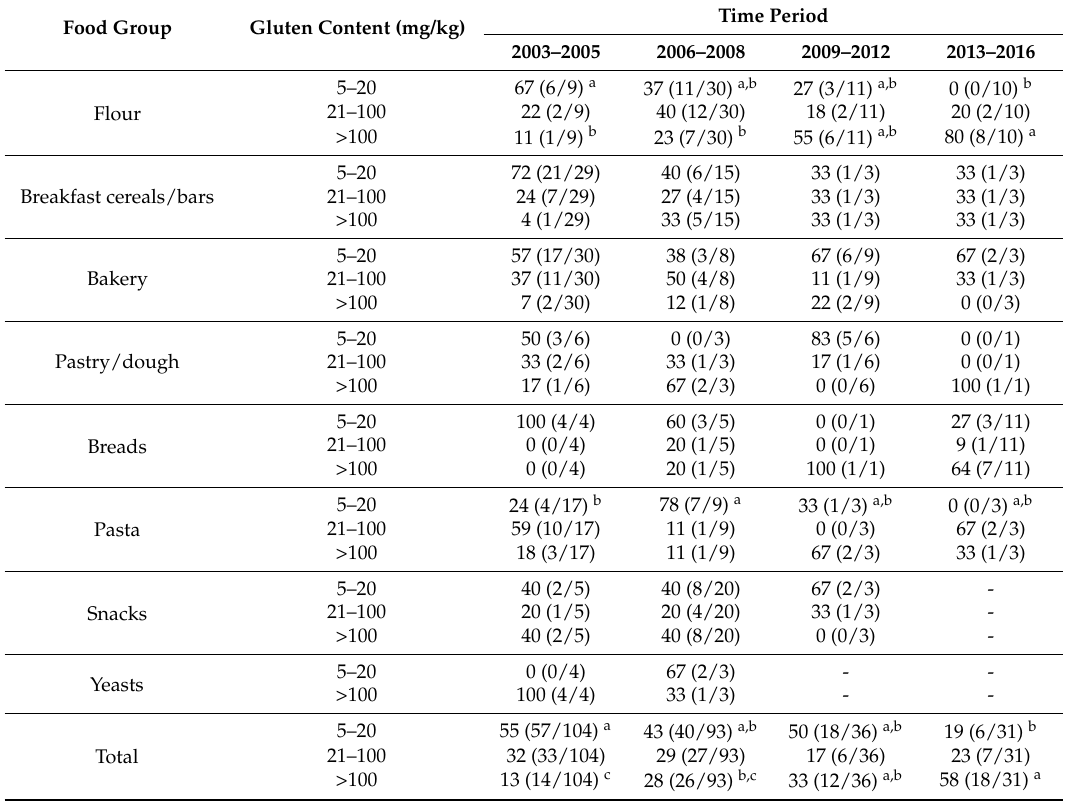
Table 2. Time-period comparison of gluten-detected samples. Table 2. Time ‐ period comparison of gluten ‐ detected samples.